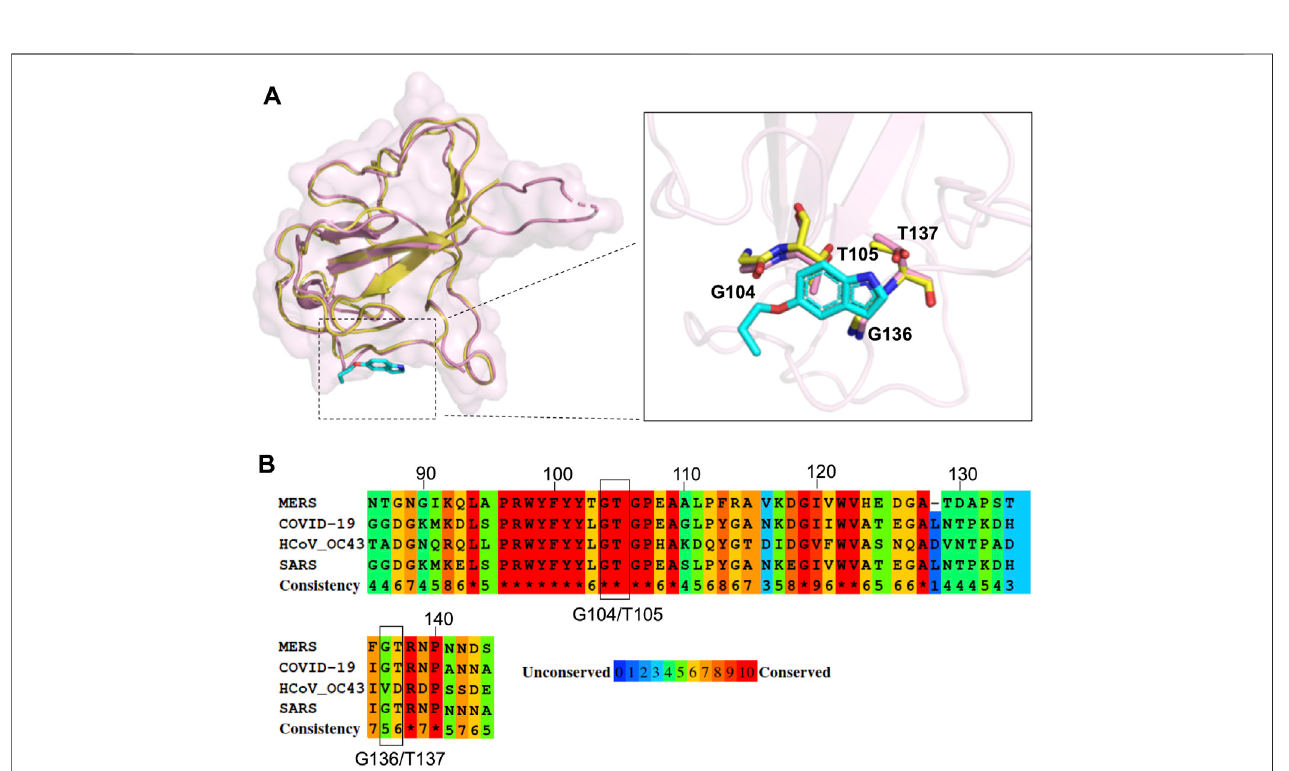
FIGURE 6 | Structural comparison of MERS CoV N-NTD with that of SARS-CoV-2 at P4 binding surface. (A) The structure of P4-1:MERS CoV N-NTD complex (yellow) was aligned to SARS-CoV-2 N-NTD (PDB: 6M3M), the interacting residues are highlighted in right box. (B) Protein sequence alignment of N-NTD of various CoVs.